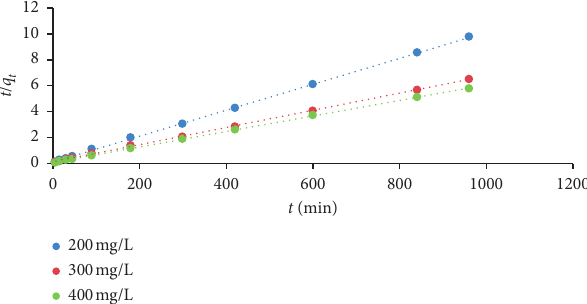
Figure 6: The second-order dynamic model for MnO